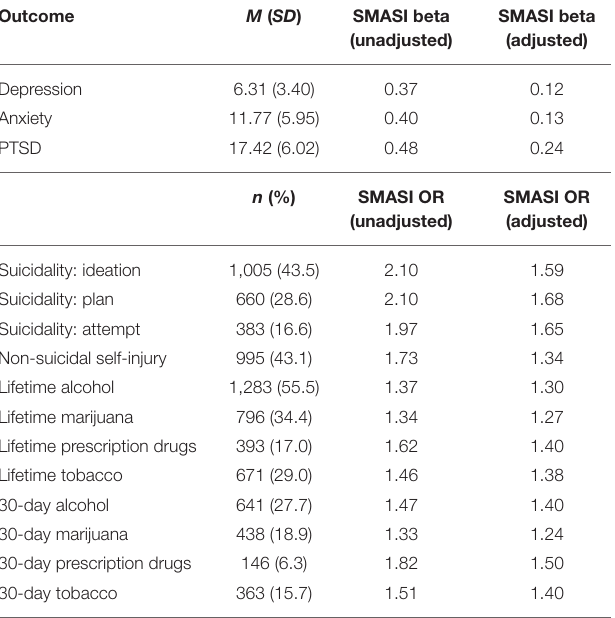
SMASI beta (unadjusted) (adjusted)